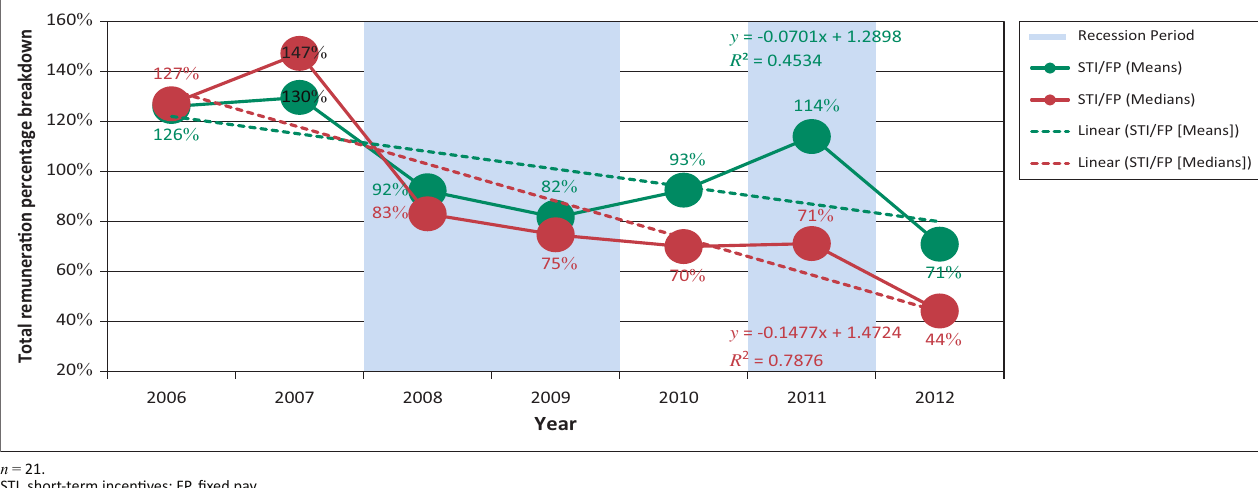
FIGURE 5: Short-term incentive/fixed pay ratios